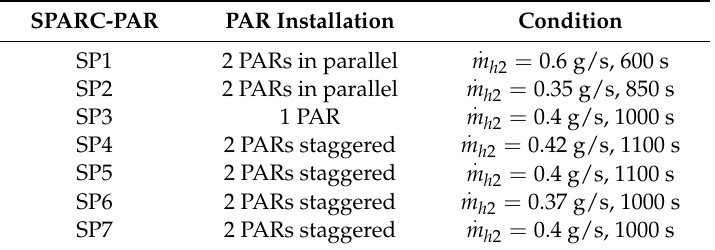
Table 3. Test conditions for the SPARC ‐ PAR experiment.